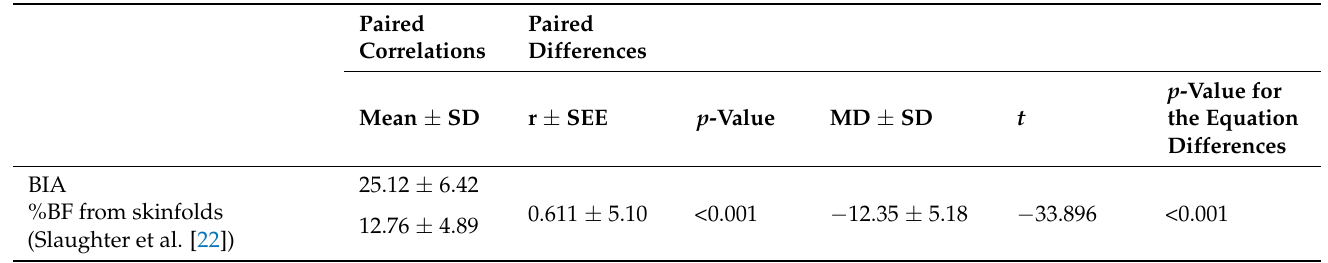
Table 3. Difference between the percentage body fat (%BF) obtained from bioelectrical impedance analysis (BIA) and the skinfold equations for the total